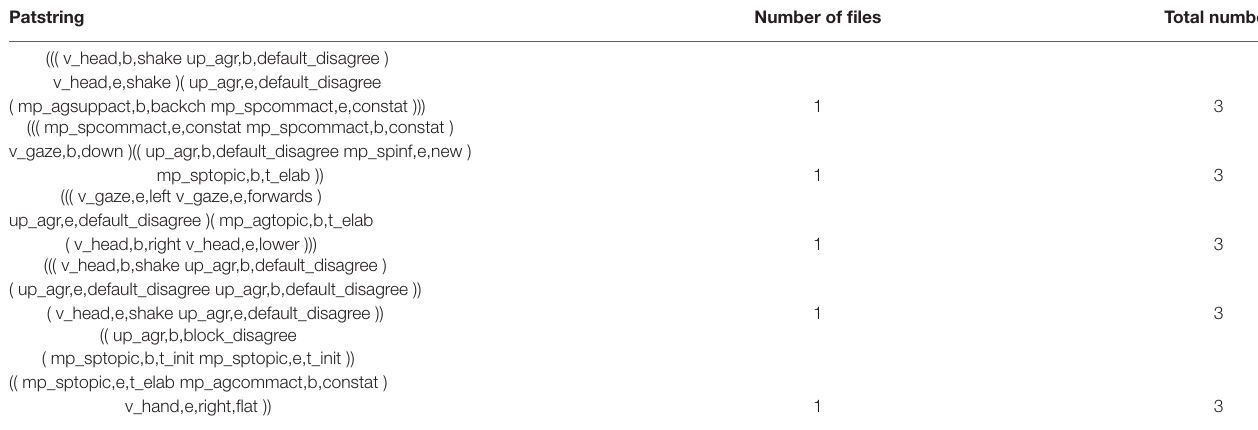
TABLE 14 | The most frequent patterns of agreement consisting of 6 events. Patstring Number of